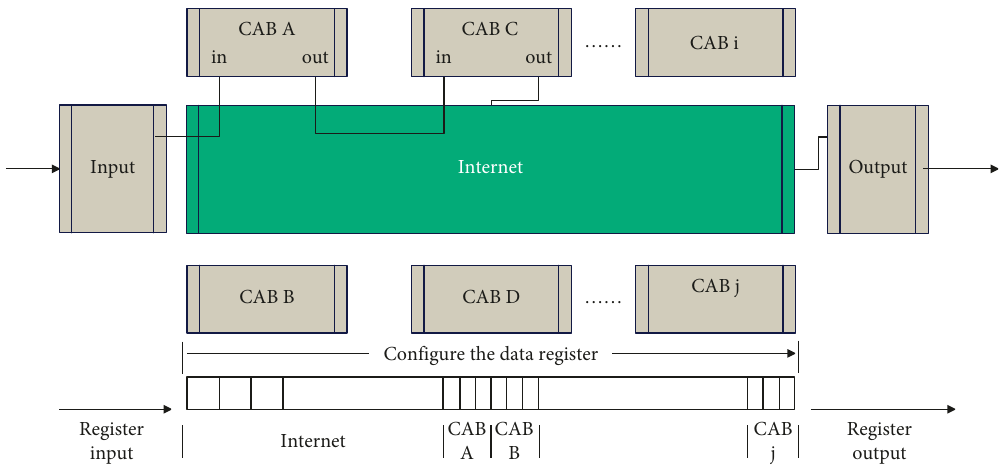
Figure 1: Principle of programmable analog array.